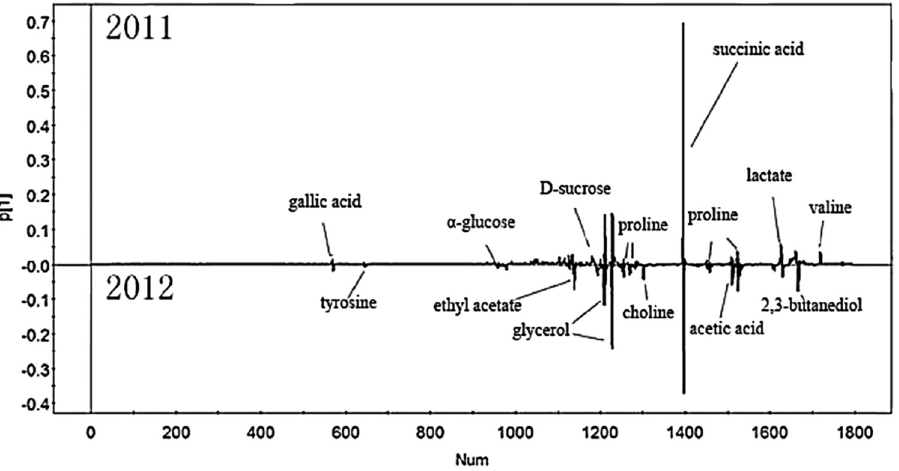
Figure 20: PLS - DA loading plot chart from 1 H NMR spectra of 2011 and 2012 vintage Cabernet Sauvignon